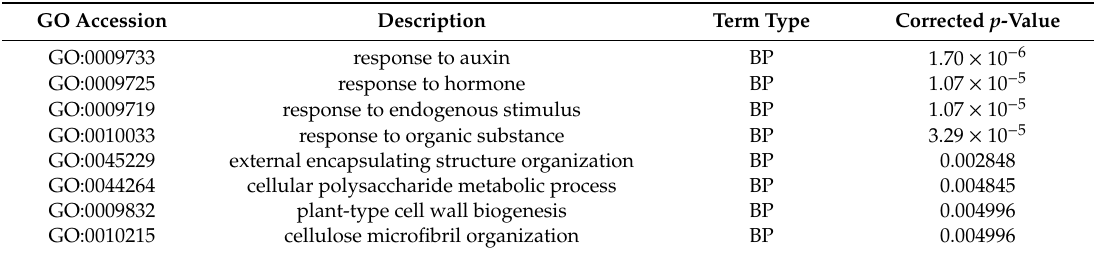
Table 3. Enriched GO terms for the downregulated DEGs in CEVd-infected citron